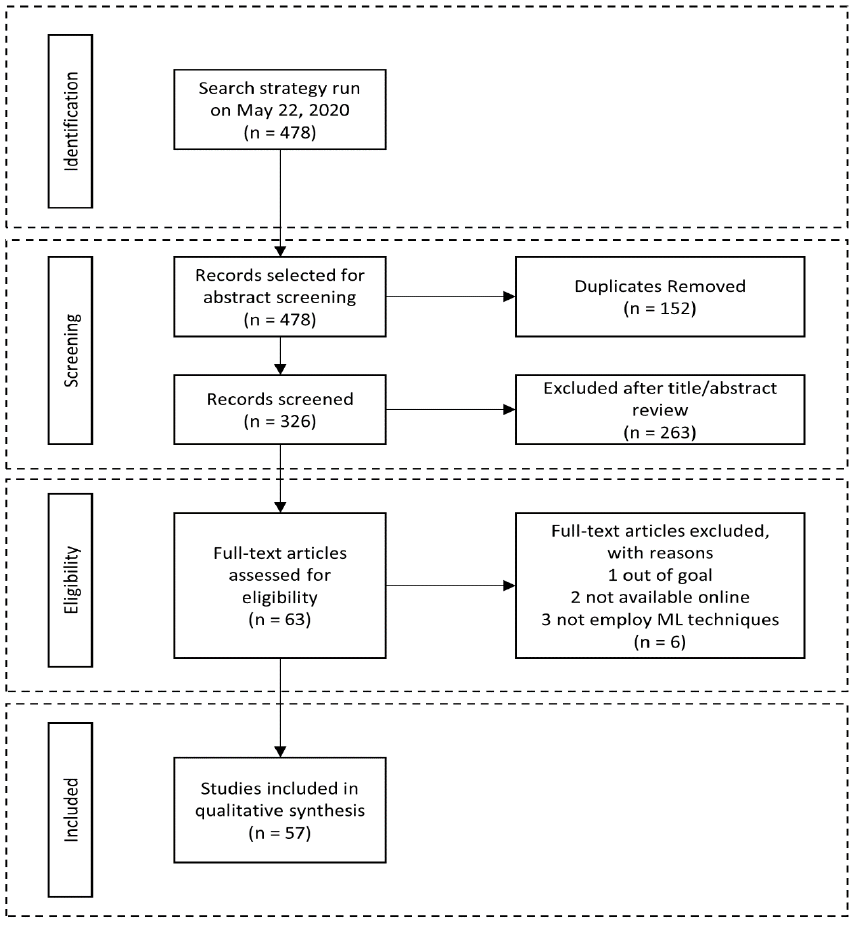
Figure 1. Flow diagram of literature search and selection criteria.